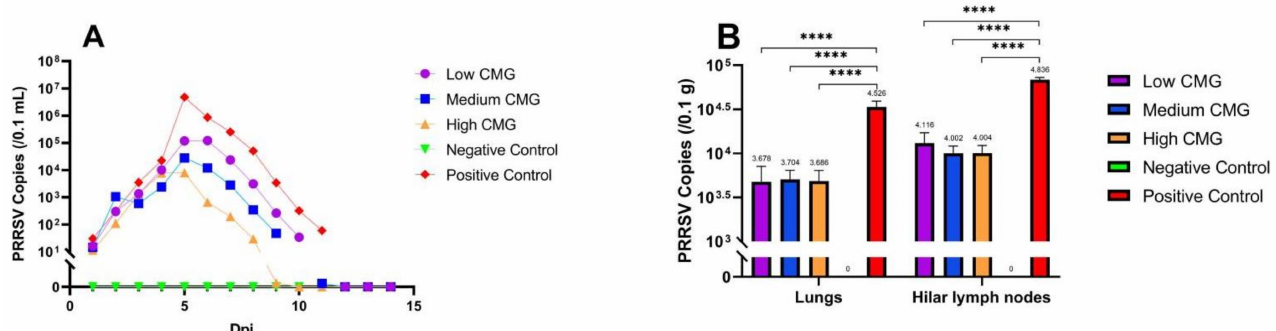
Figure 4. Viral load detection in piglets infected with PRRSV. ( A ): Changes in viral load in nasal swabs of the five groups of piglets for 14 consecutive days; ( B ): Comparison of viral loads in the lungs and hilar lymph nodes of the five groups of piglets. **** p <